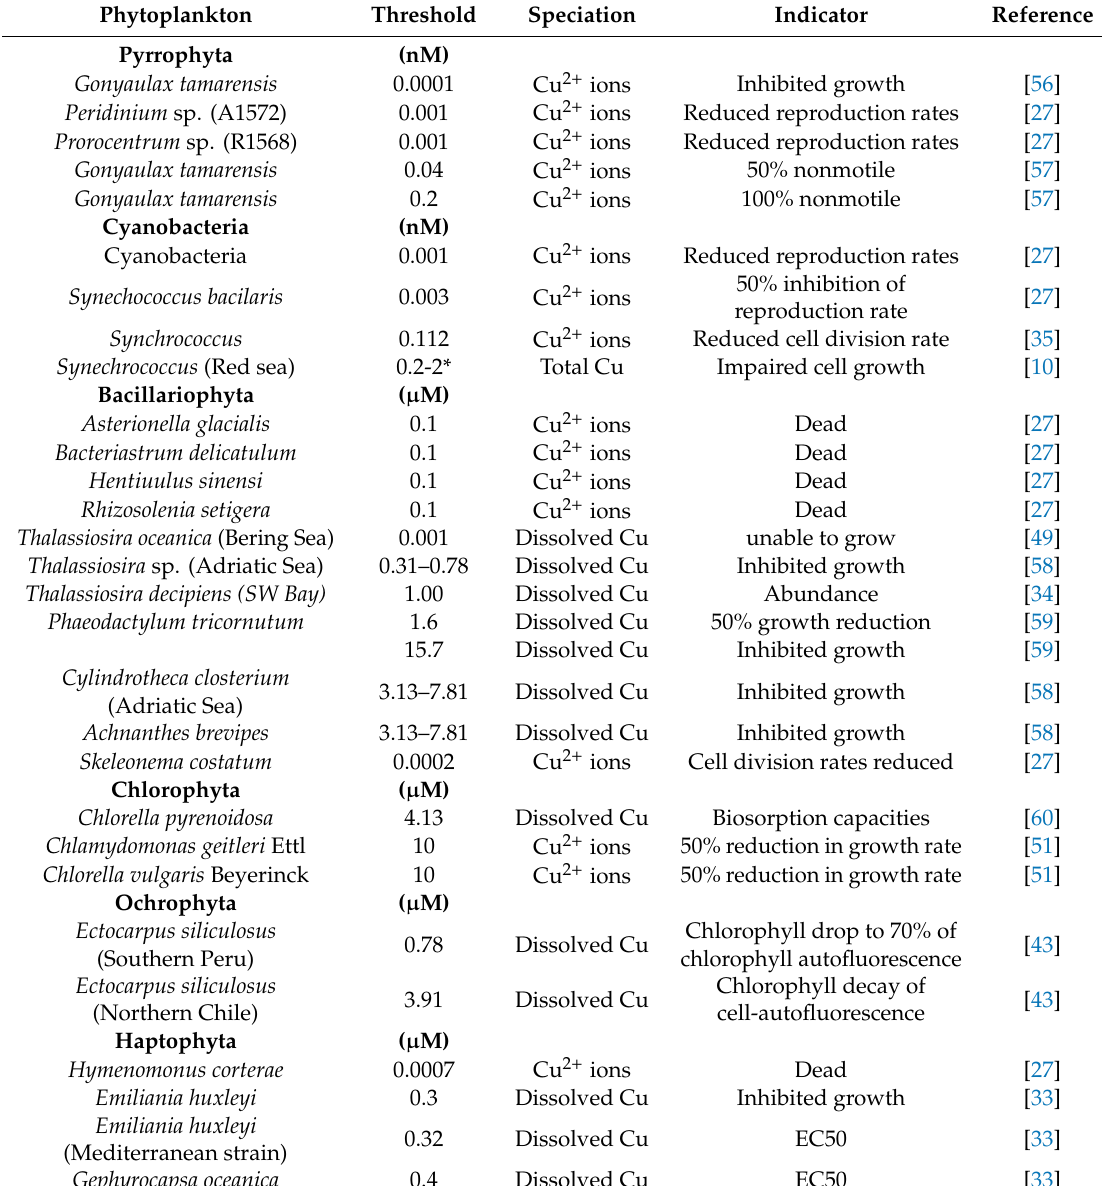
Table 1. Toxicity thresholds of Cu for di ff erent phytoplankton